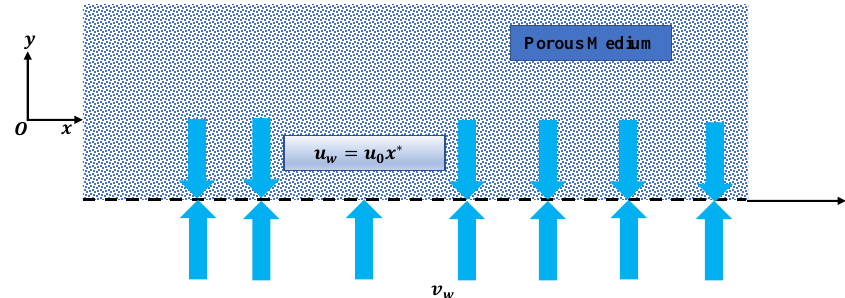
Figure 2. A schematic view of the physical